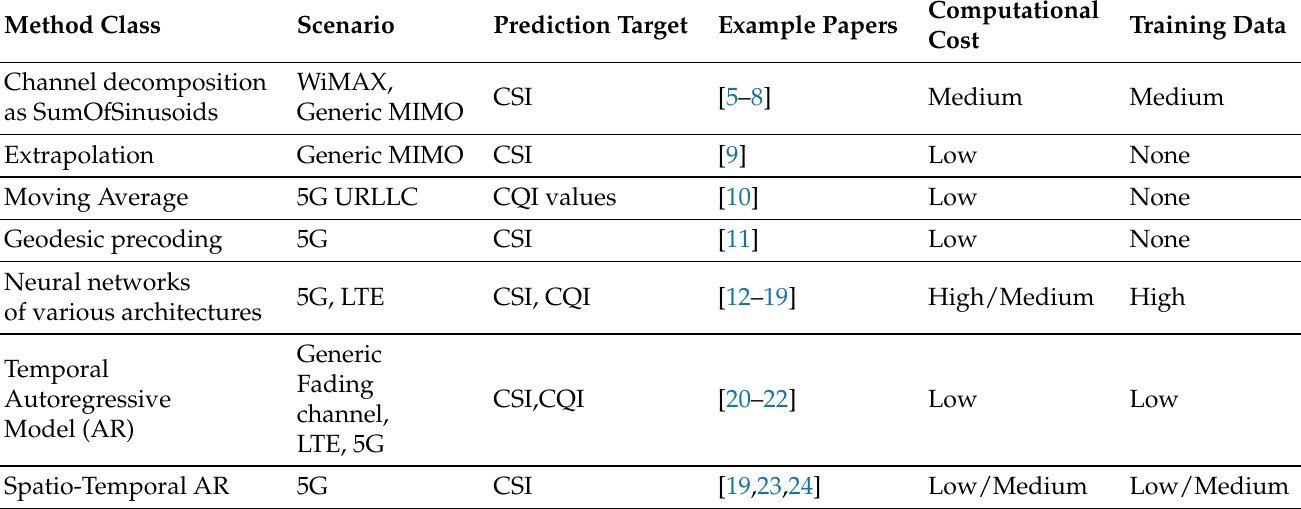
Table 1. Related works on channel